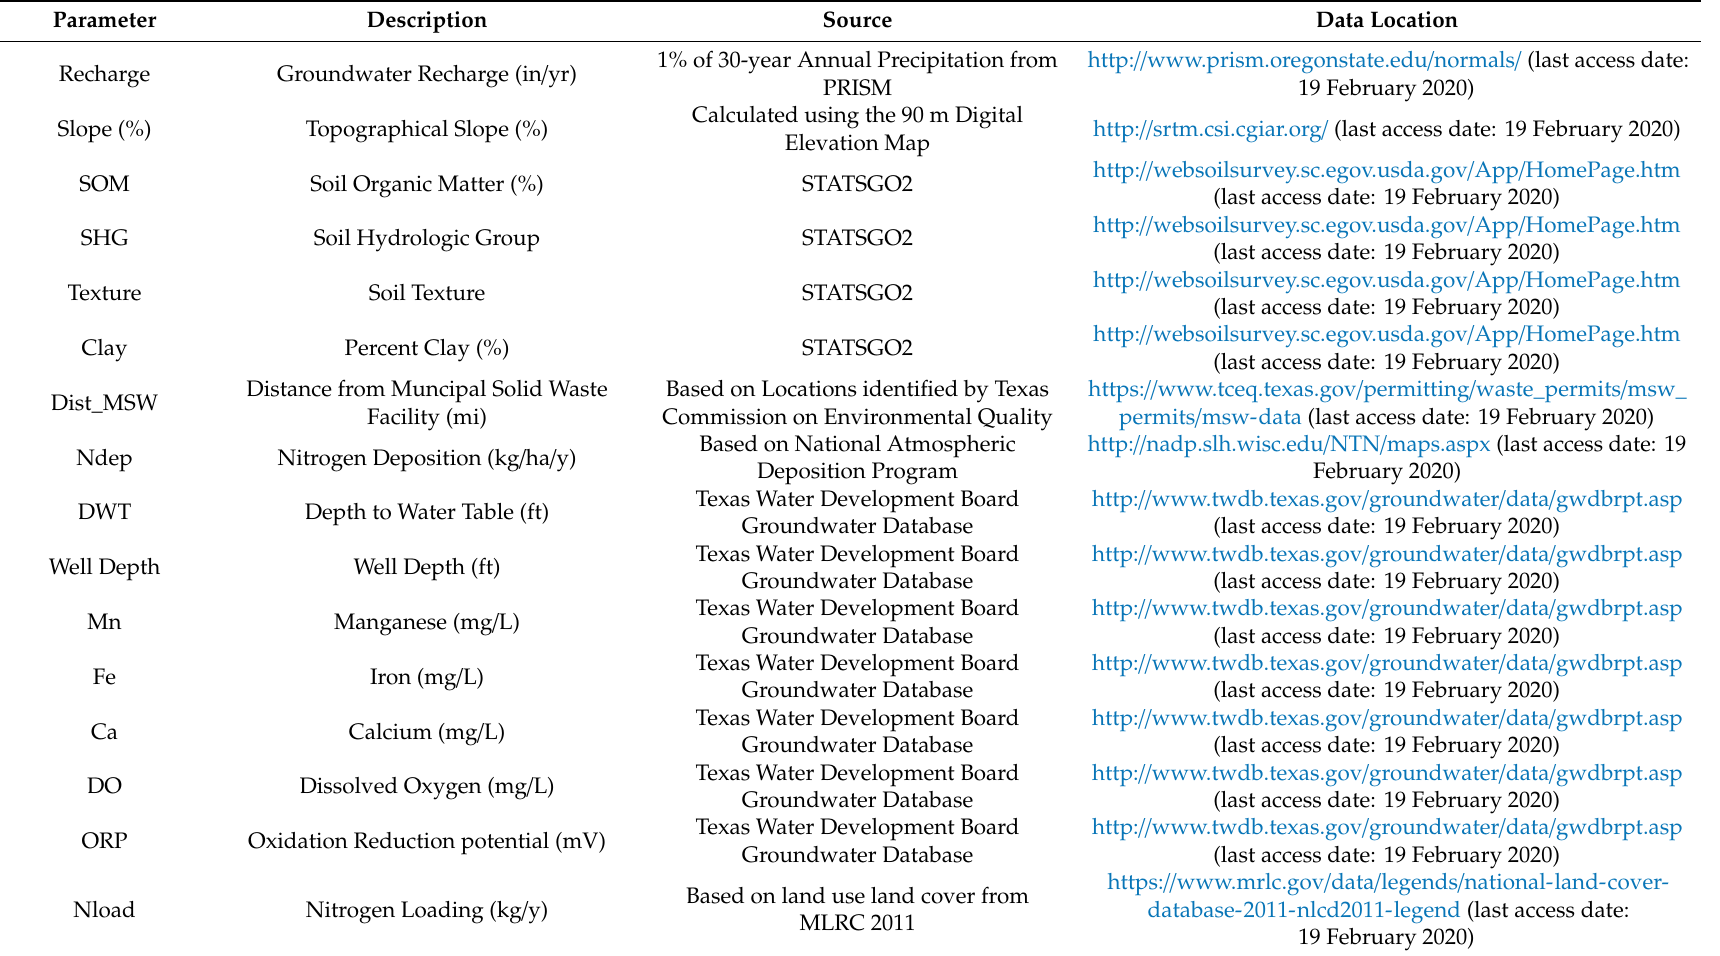
Table 1. Input Parameters Considered in this Study to Model Nitrate Exceedances and their Data